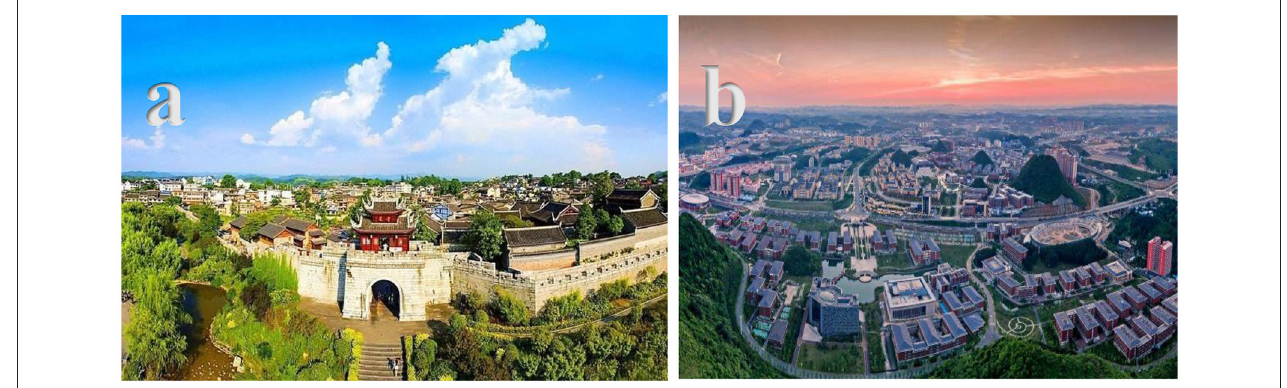
FIGURE 6 | Qingyan Ancient Town in Gui’an New District (a) ; University Town in Gui’an New District (b) (Photographed by authors).